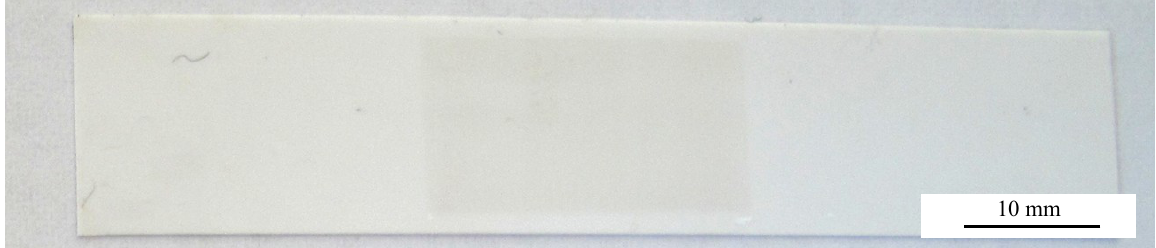
O AD layer on an alumina substrate after deposition. 2 3 , film thickness t ≈ 8 2